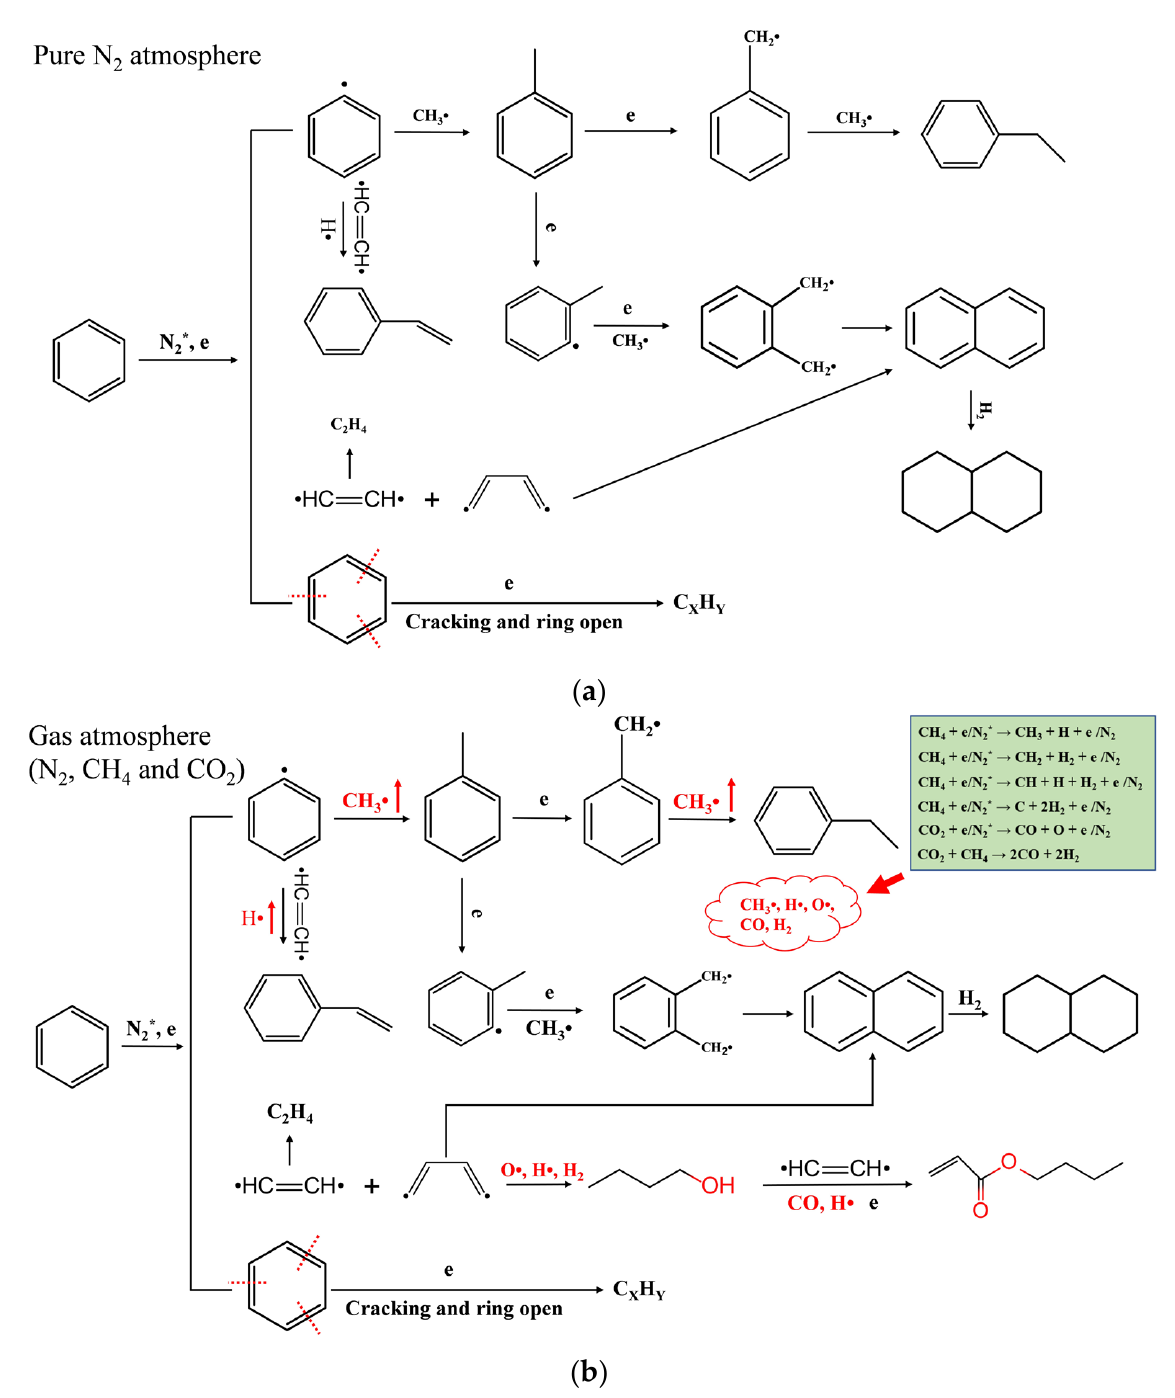
Figure 6. Proposed reaction mechanism for benzene reforming under ( a ) a pure N 2 atmosphere and ( b ) a gas mixture (N 2 , CH 4 and CO 2 ) atmosphere over a La − Ni/ γ− Al 2 O 3 catalyst in the DBD plasma reactor.